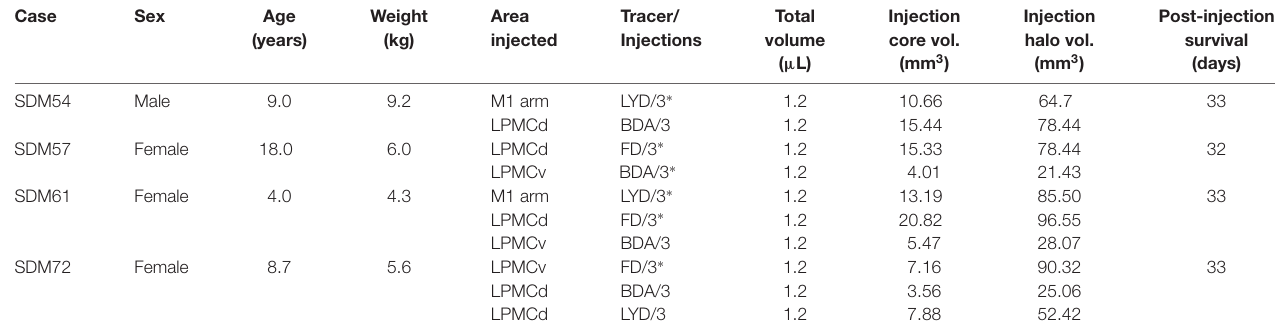
TABLE 1 | Description of the experimental parameters in each case. Case Sex Age Weight Area Tracer/ Total Injection Injection Post-injection (years) (kg) injected Injections volume core